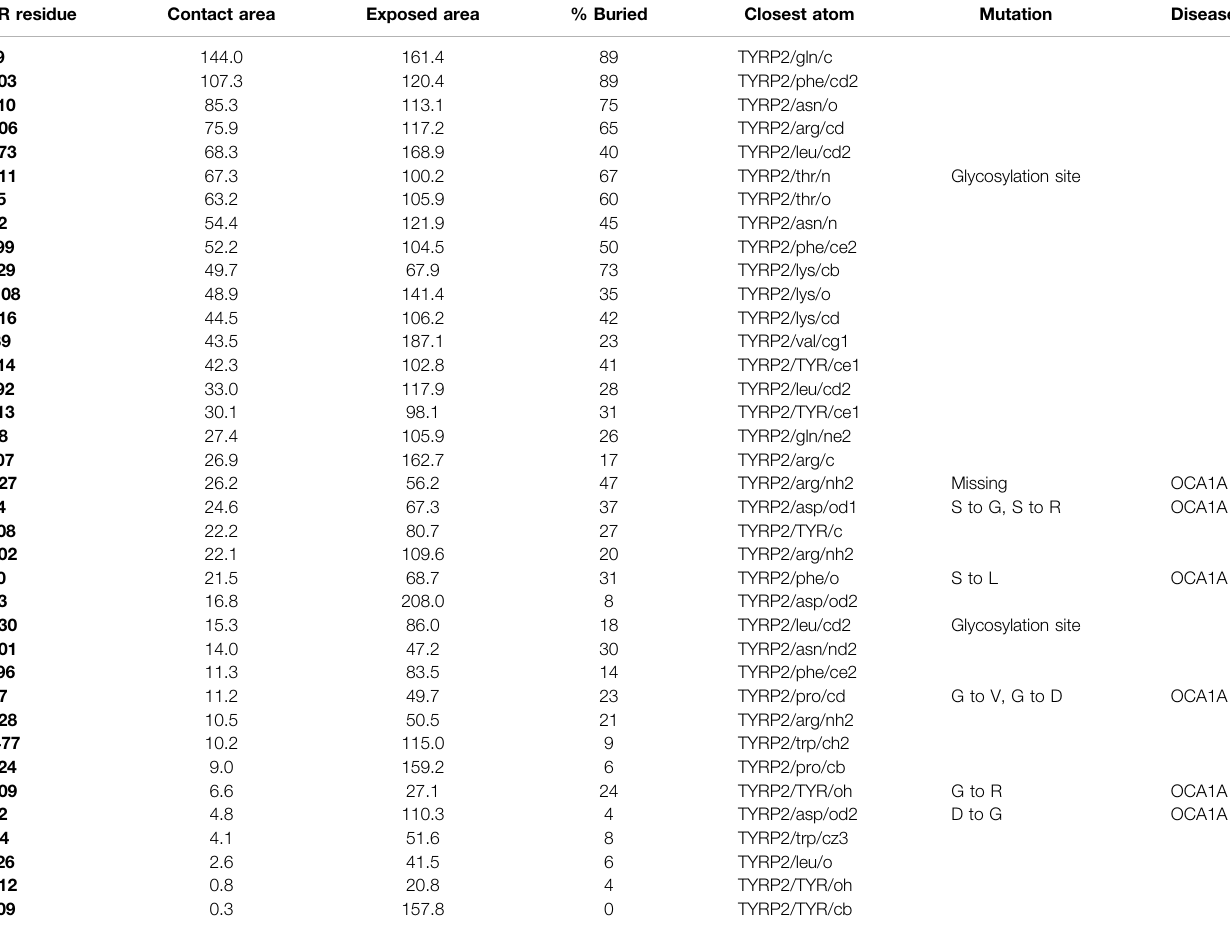
TABLE 2 | Residue contacts at the TYR-TYRP2 binding interface. Contact residues on TYRare ranked bydecreasingstrength ofinteractions, determined byacombination of contact area, exposed area, percentage of contact area compared to exposed (% buried) and closest distance to the atom on TYRP2. TYR